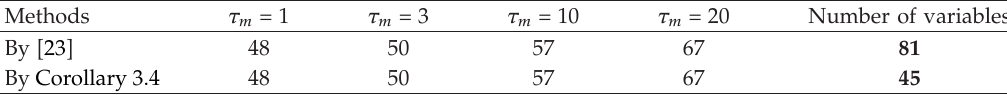
Table 1: Comparisons of allowable upper bound (cid:2) τ Table 2: Comparisons of allowable upper bound (cid:2) τ